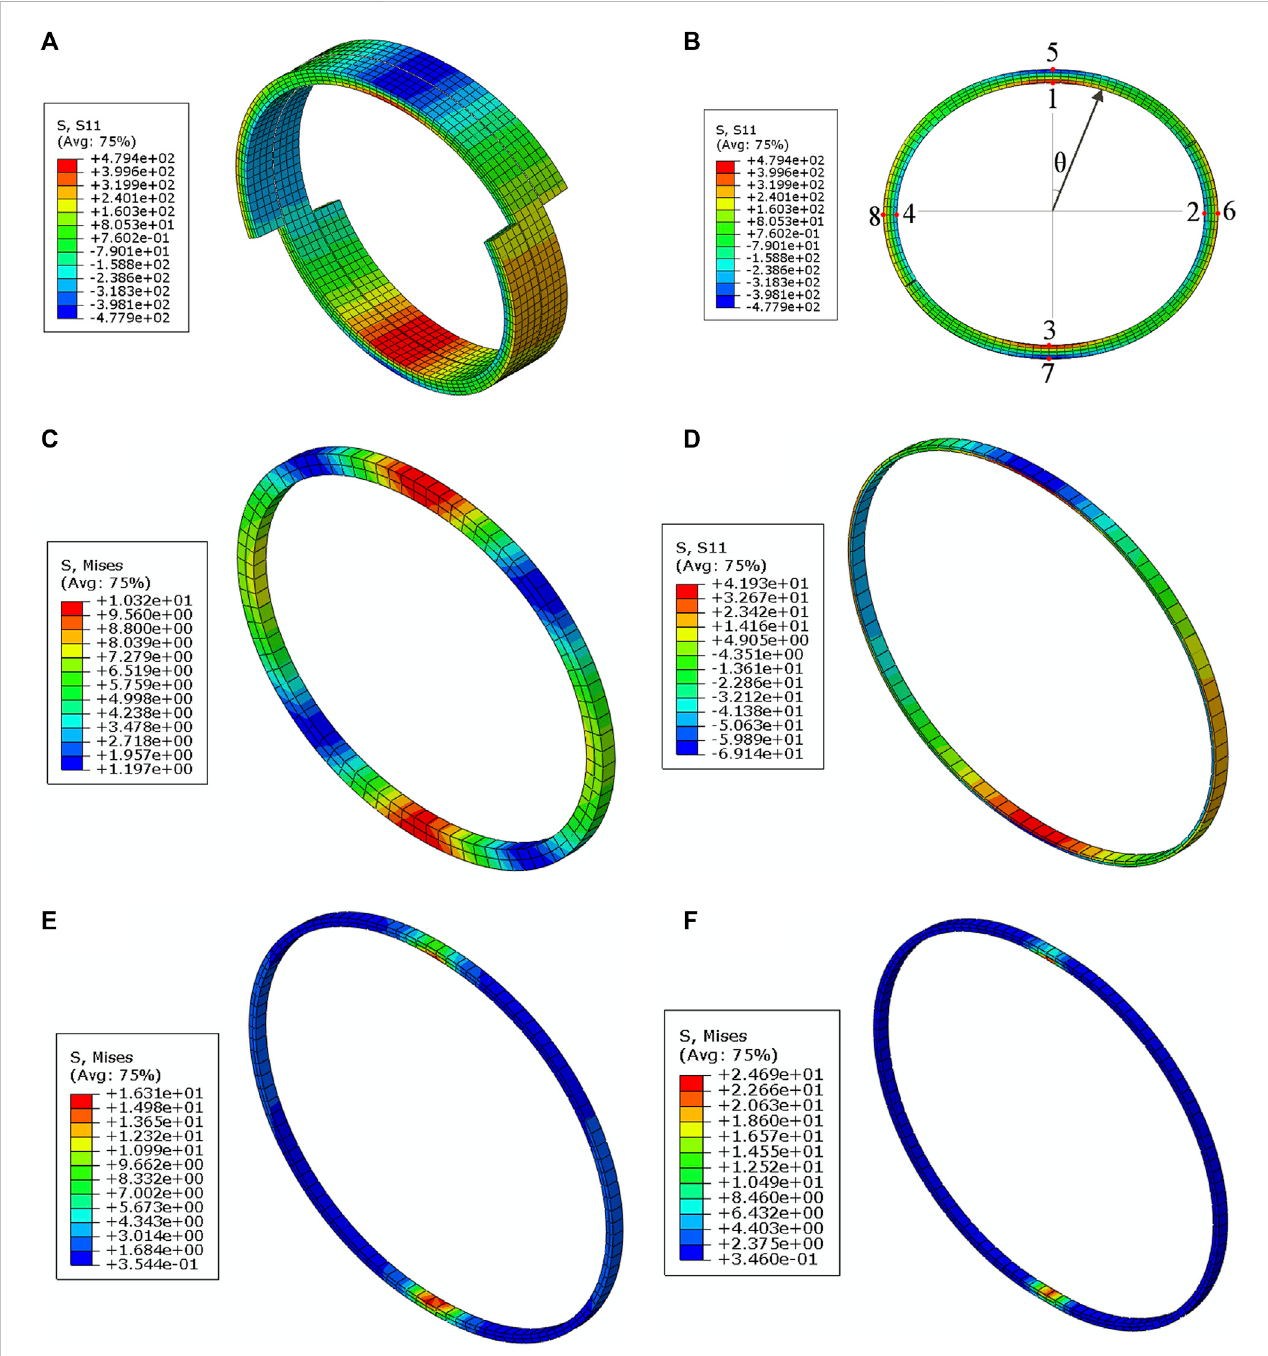
Contour images of the stress distribution of the pipe layers (A) ISO view of fi bre-direction stress of the hoop reinforcement layer. (B) Front view of fi bre- direction stress of the hoop reinforcement layer. (C) Mises stress of the liner. ( D) Fibre-direction stress of the inner hoop layer. (E) Mises stress of the membrane. (F) Mises stress of the outer